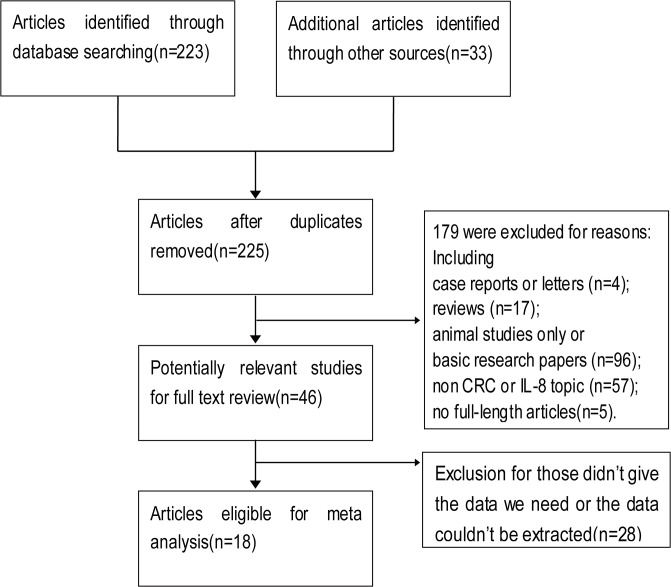
Flow diagram of study selection procedure.